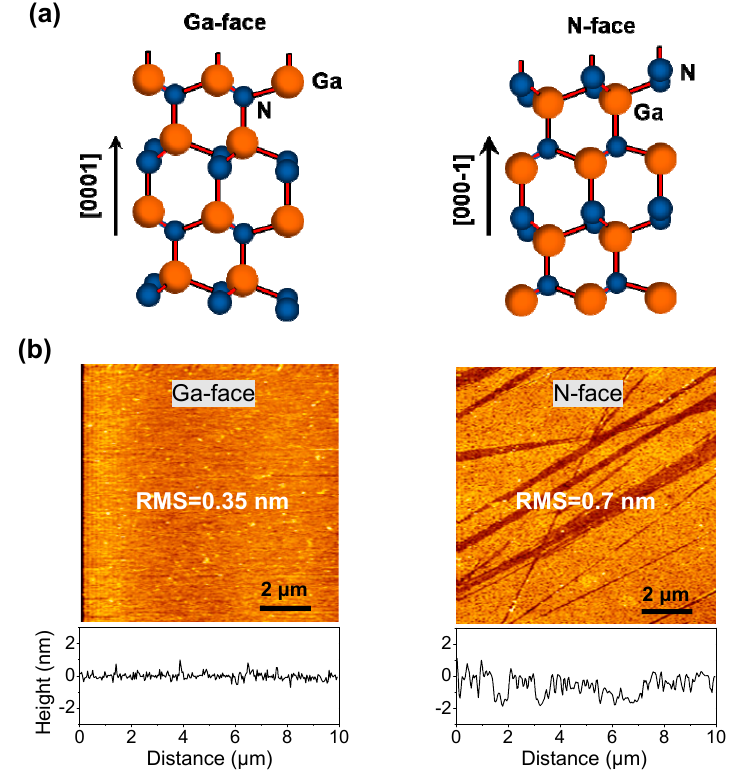
Figure 1. ( a ) Schematic diagram showing the different atomic arrangements of Ga- and N-faced c-plane gallium nitride (GaN) with the wurtzite crystal structure; ( b ) atomic force microscope (AFM) surface images and cross-sectional profiles of the Ga-face and N-face of a GaN sample in our